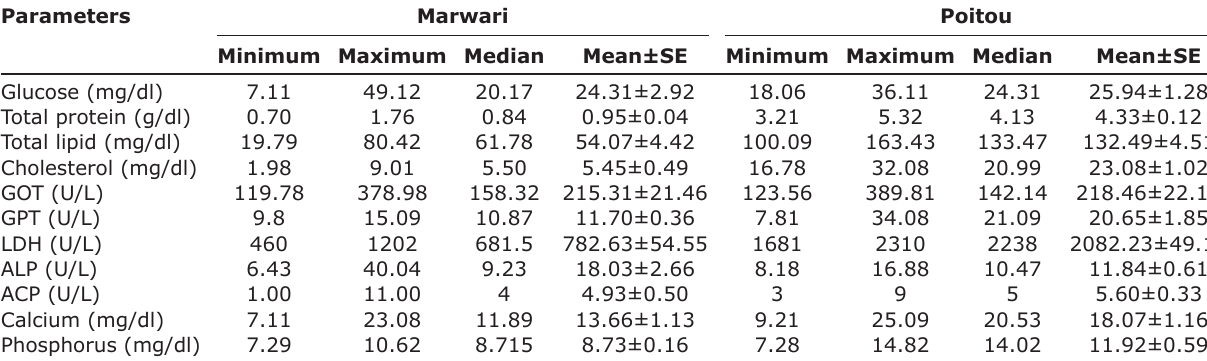
Table 2: Mean±SE biochemical attributes of semen ejaculates of the Marwari and Poitou Stallions.